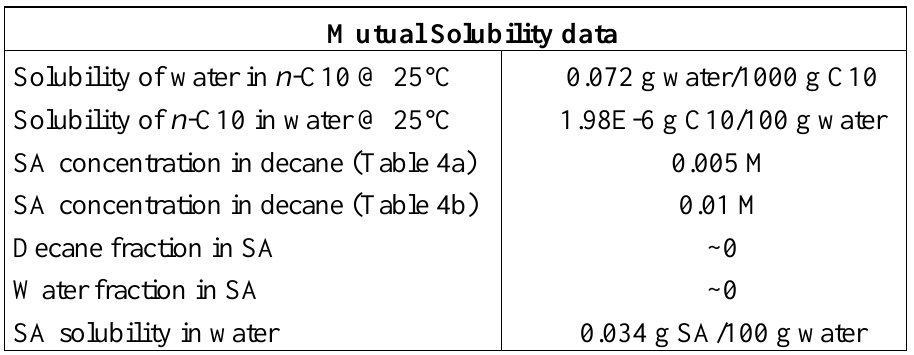
Table 3. Applied mutual solubility data in water/SA/decane system for IFT